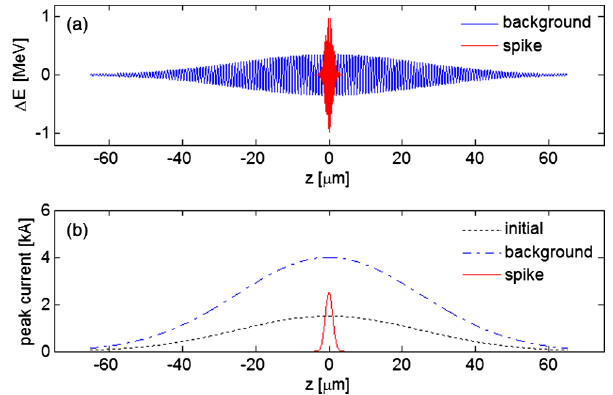
FIG. 2. Longitudinal energy (a) and microbunch peak current (b) distribution prior to the drift. The central spike is responsible for LSC-EEHG seeding, while the longer background pulse is responsible for suppression of the lasing from SASE. The central spike of energy modulation is initially folded over while the less energy-modulated portion is maximally bunched in the first chicane. This leads to different amounts of peak current in different